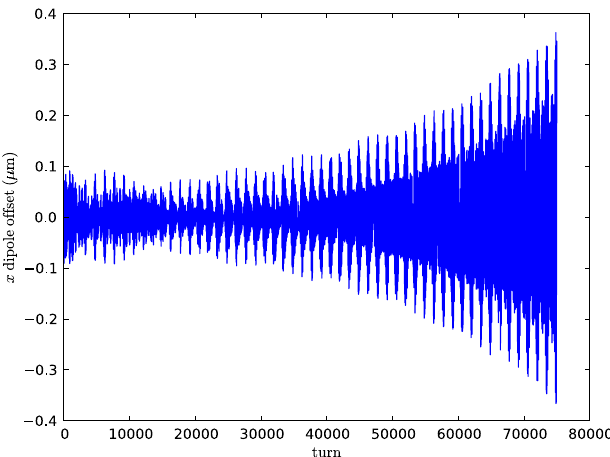
FIG. 19. (Color) The x rms moment of a representative bunch in a 36-on-36 simulation with C ¼ (cid:1) 2 with beam-beam effects and beams separated showing no obvious instability within the limits of the